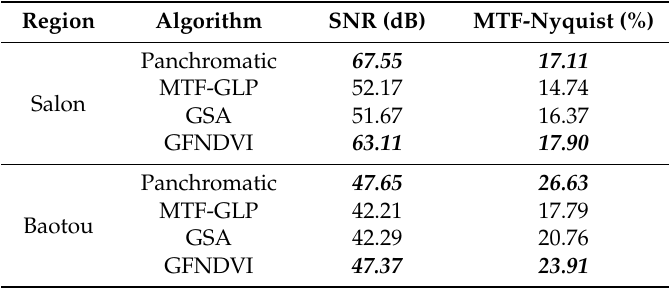
Table 4. Comparative spatial clarity results corresponding to each region. SNR: signal-to-noise ratio; MTF-Nyquist: Nyquist value based on the MTF.